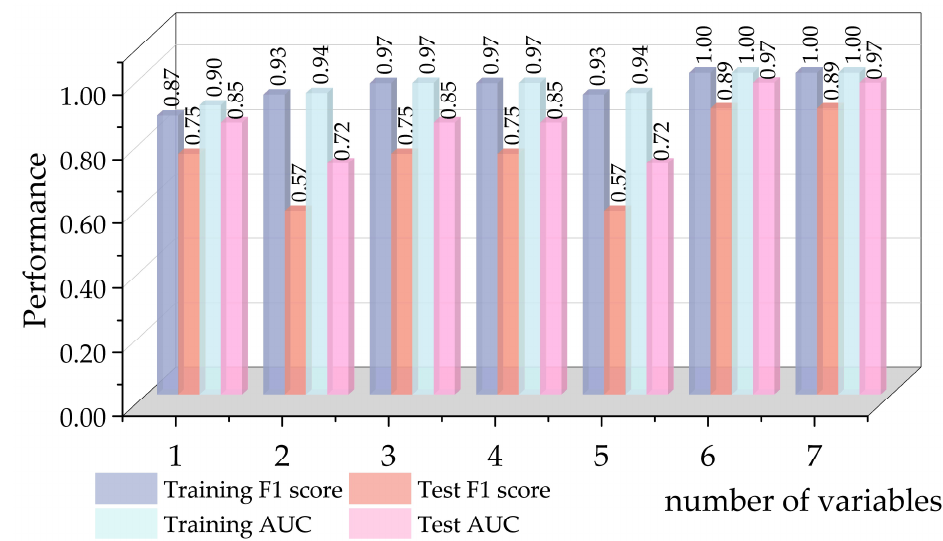
Figure 6. Performance of BO-GBDT model established by different input se(cid:308)ings on the training test and test sets.